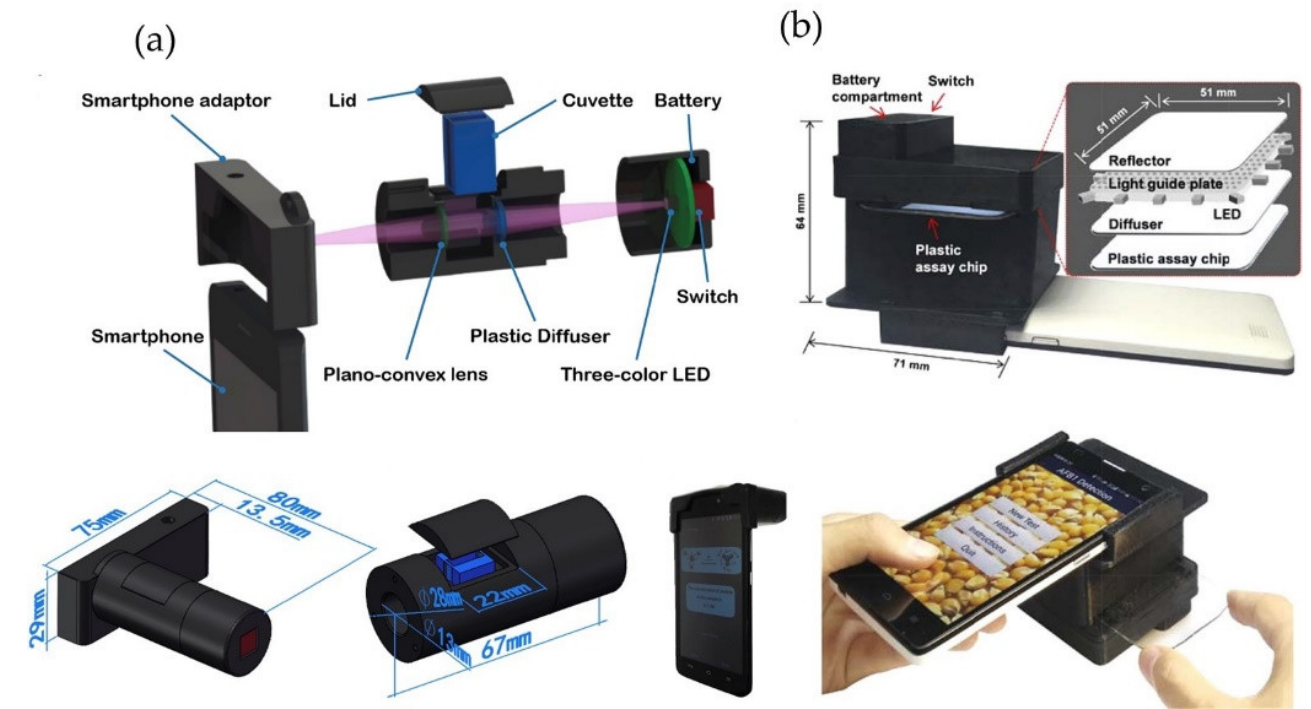
Figure 3. Examples of smartphone-based optical food analyzers: ( a ) The 3D printed smartphone optosensing platform for detection of streptomycin in honey and milk. The anti-streptomycin aptamer-conjugated gold nanoparticles are used as the colorimetric indicator. The ratio of the absorbance at 625 nm to that at 520 nm was measured as the optosensor signal. Schematic overview of the internal structure and dimensions. Reproduced from [47] Analytica Chimica Acta Copyright (2017), with permission from Elsevier; ( b ) The integrated Smartphone-App-Chip system for aflatoxin B1 detection in corn. The detection is based on an indirect competitive immunoassay in the microfluidic channel. Then the assay chip is aligned in the 3D-printed optical accessory attached to a smartphone. The image captured by the smartphone camera is directly processed using a custom-developed Android app. Reproduced with permission from [48] Analytical Chemistry, Copy right (2017), American Chemical Society.